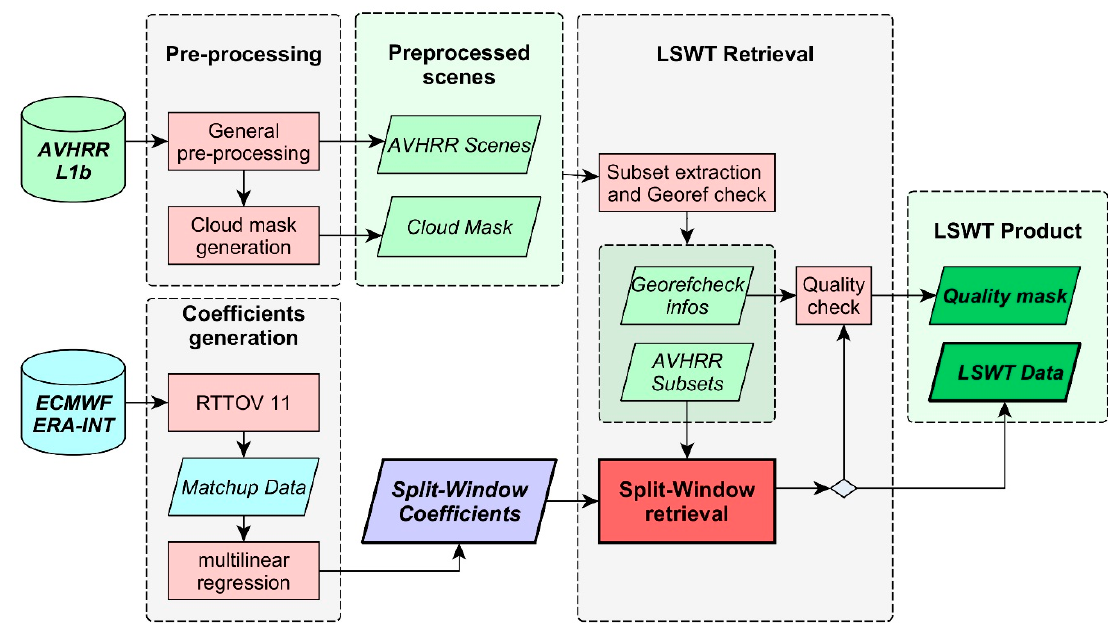
Figure 3. Schematic representation of the LSWT processing as used for this work.